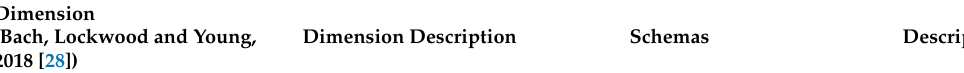
Table 1. Description of early maladaptive schemas